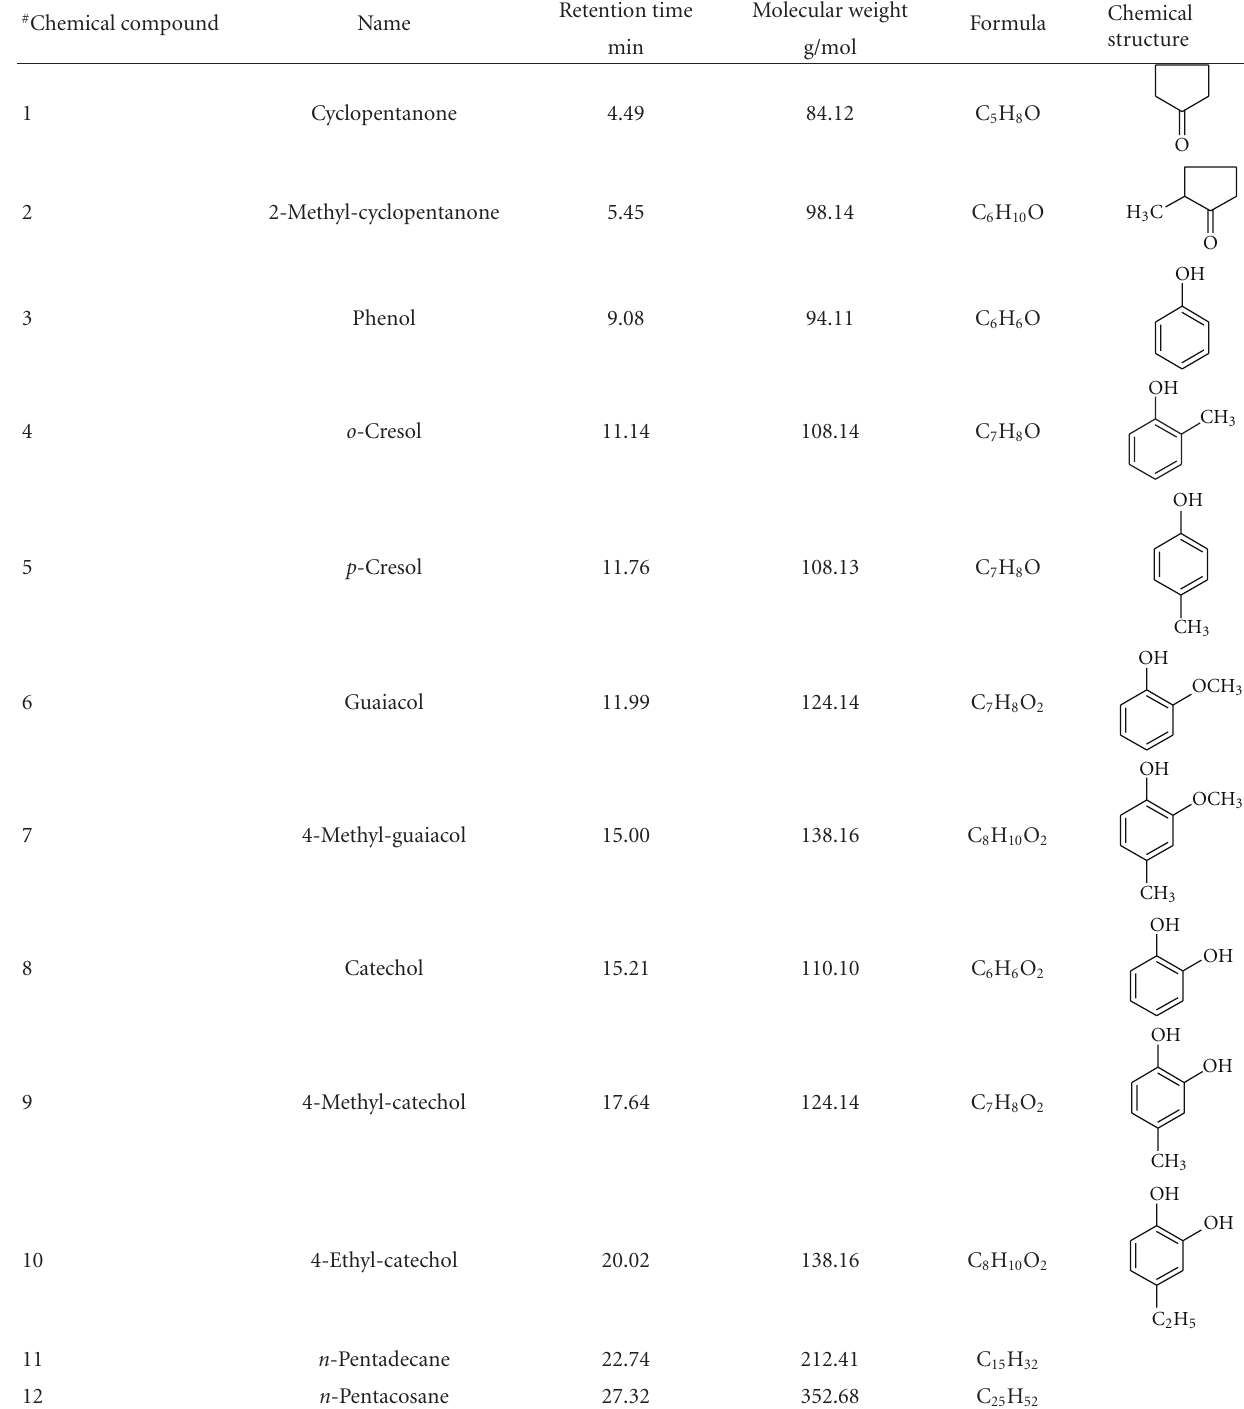
Table 1: Chemical compounds detected by GC-FID (see Figure